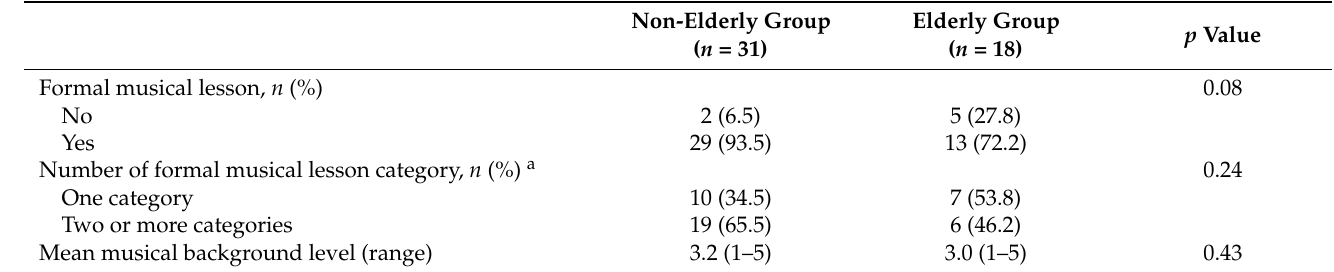
Table 2. Comparison of formal musical training and musical background between the non-elderly and elderly groups.